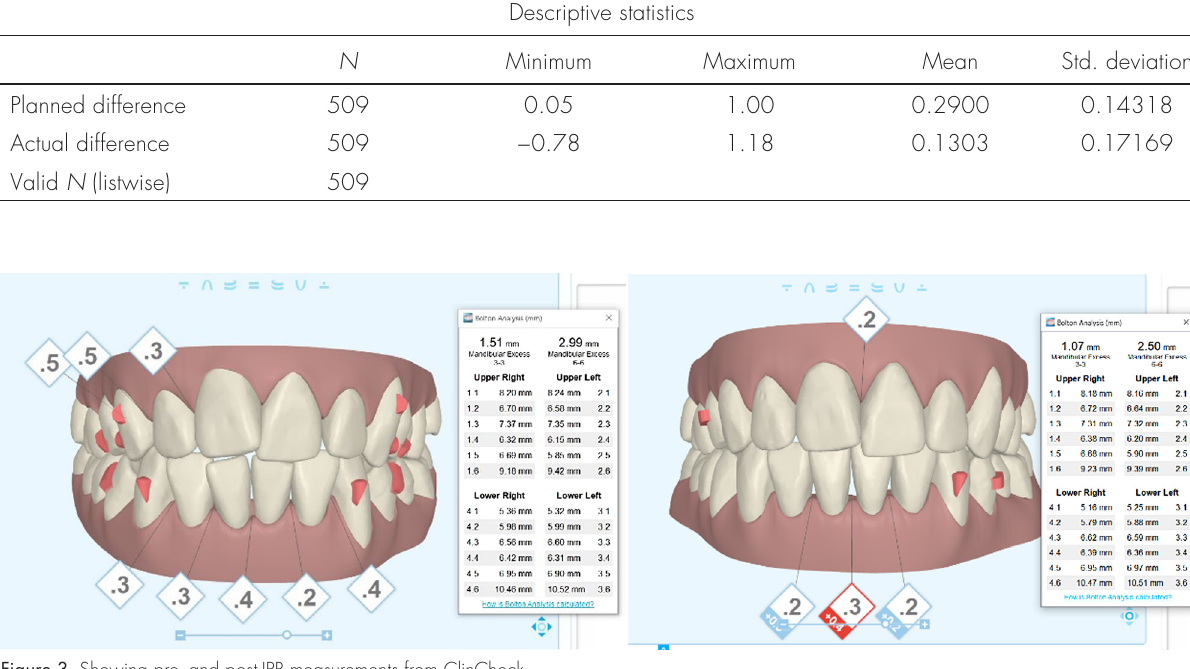
Figure 3. Showing pre- and post-IPR measurements from ClinCheck.